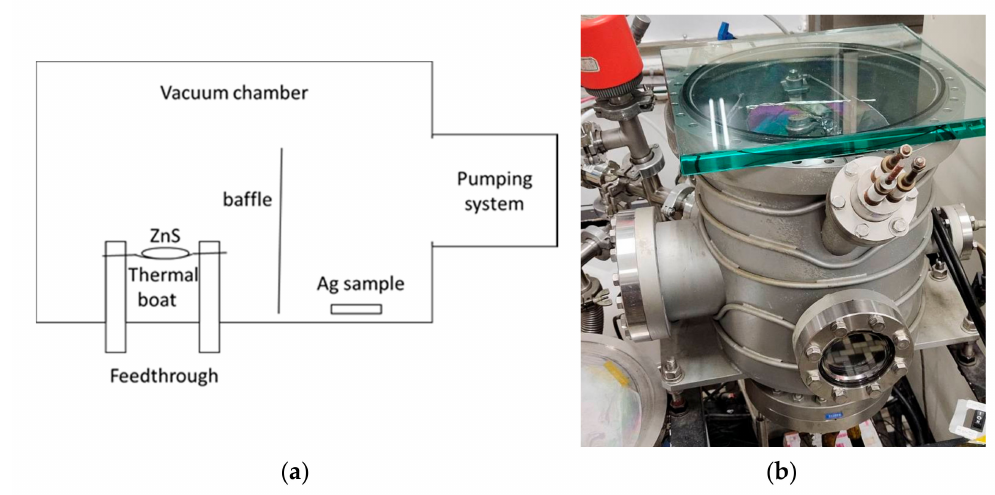
Figure 3. ( a ) schematic diagram of sulfurization chamber, ( b ) photo of the homemade sulfuriza- tion